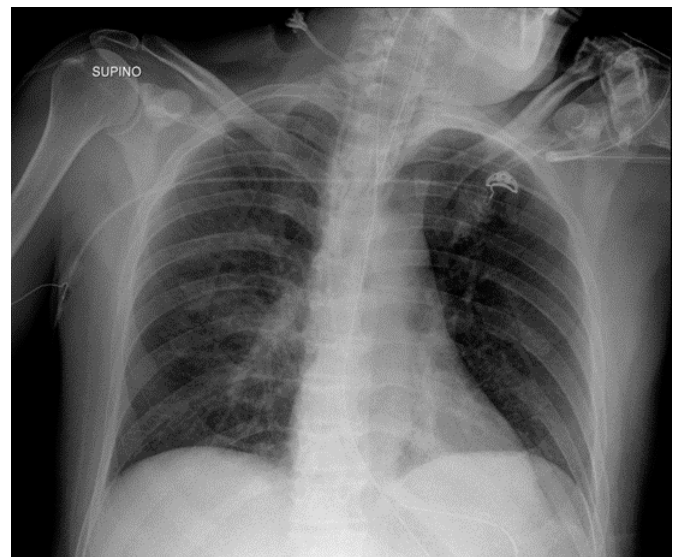
Figure 10. Image of a well-positioned ETT: tip ~5 cm from the carina (right above the aortic knob), no balloon overinflation. In the radiogram, an adequately positioned nasogastric tube whose tip lies in the cardial region of the stomach is visible, after looping along the greater curvature.